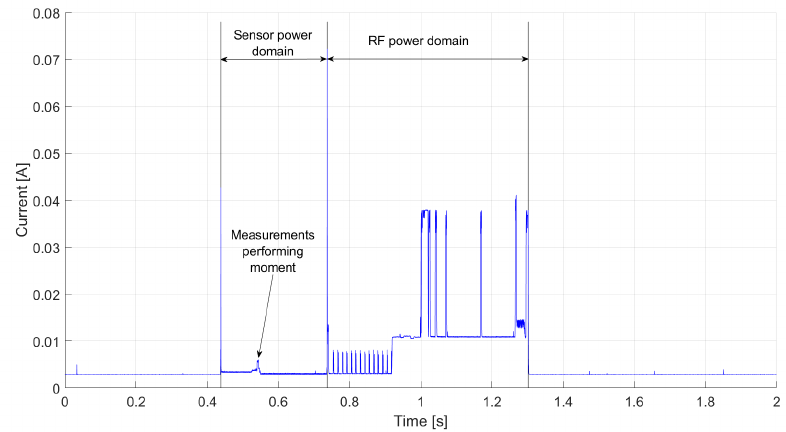
Figure 19. Current consumption of the WSM.